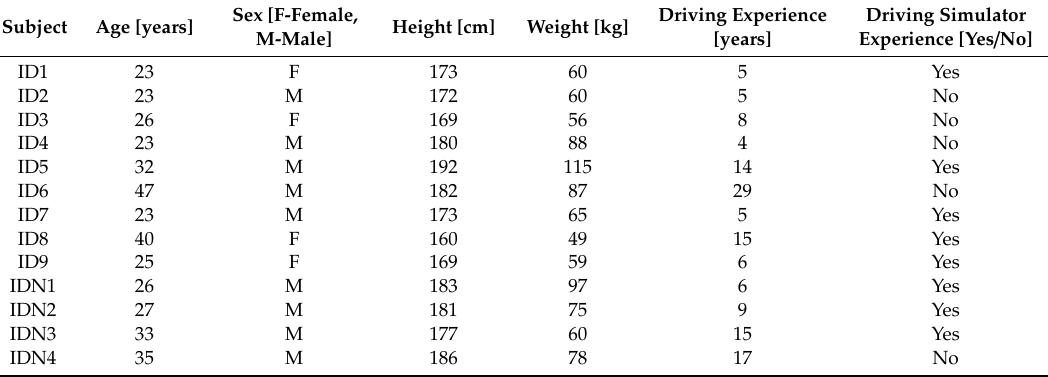
Table 1. Demographic data for subjects included in the study, with information about their driving and simulation experience. Only participants with ID1-ID9 were included in the EGG